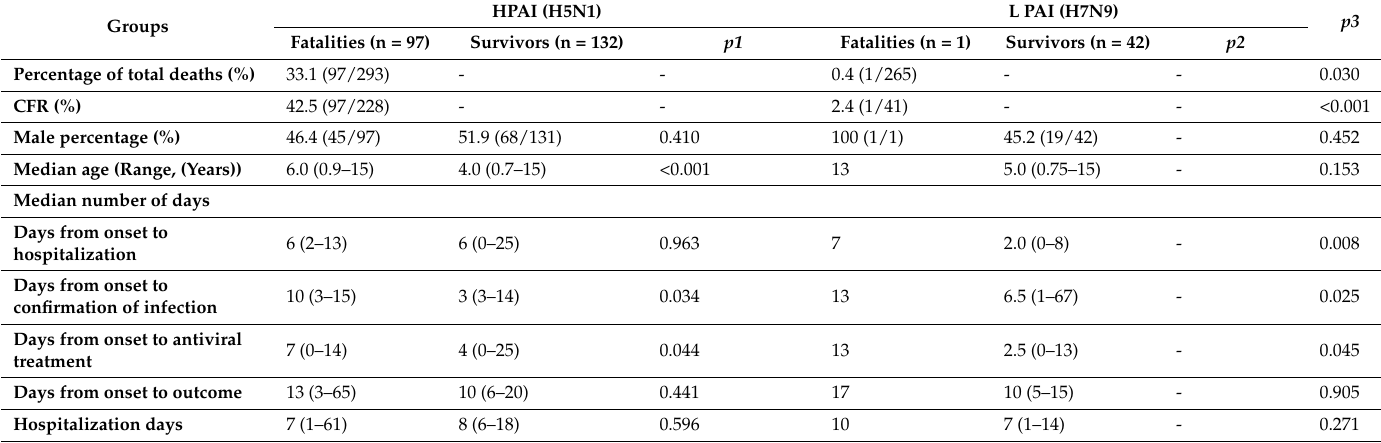
Table 2. Highly pathogenic avian influenza and low pathogenicity avian influenza: An epidemiological and clinical comparison of pediatric fatalities and survivors. HPAI (H5N1) L PAI (H7N9) Groups Survivors (n = 132) p1 Percentage of total deaths